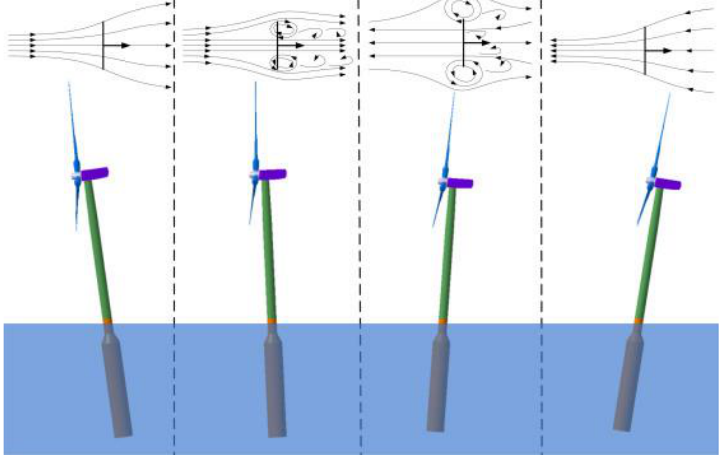
Figure 1. This disturbed flow field due to strong interactions of FOWT’s aero-hydrodynamics [11]. In addition to the strong interactions between aerodynamics and hydrodynamics of FOWTs, another key factor is the aeroelastic due to the notable feature of the increasing rotor diameter. As previously mentioned, the LCOE of FOWTs is more expansive than that of the onshore wind turbines. The technology advancements in rated power for offshore wind turbines will bring a considerable cost reduction, approximately 8.5%, and is significantly better than the advancements in aerodynamics and floating platform design and installation [12]. Consequently, the development trend of FOWTs towards a large size, with the aim to be more commercially affordable, which makes the aeroelastic responses of the wind turbine blades very prominent. It is known that the aerodynamic performance of wind turbines is reduced by the aeroelastic responses. Additionally, the issues of fatigue loads and structural failure for wind turbine blades are more urgent, particularly under severe sea conditions. Therefore, with the great advancements of FOWTs towards